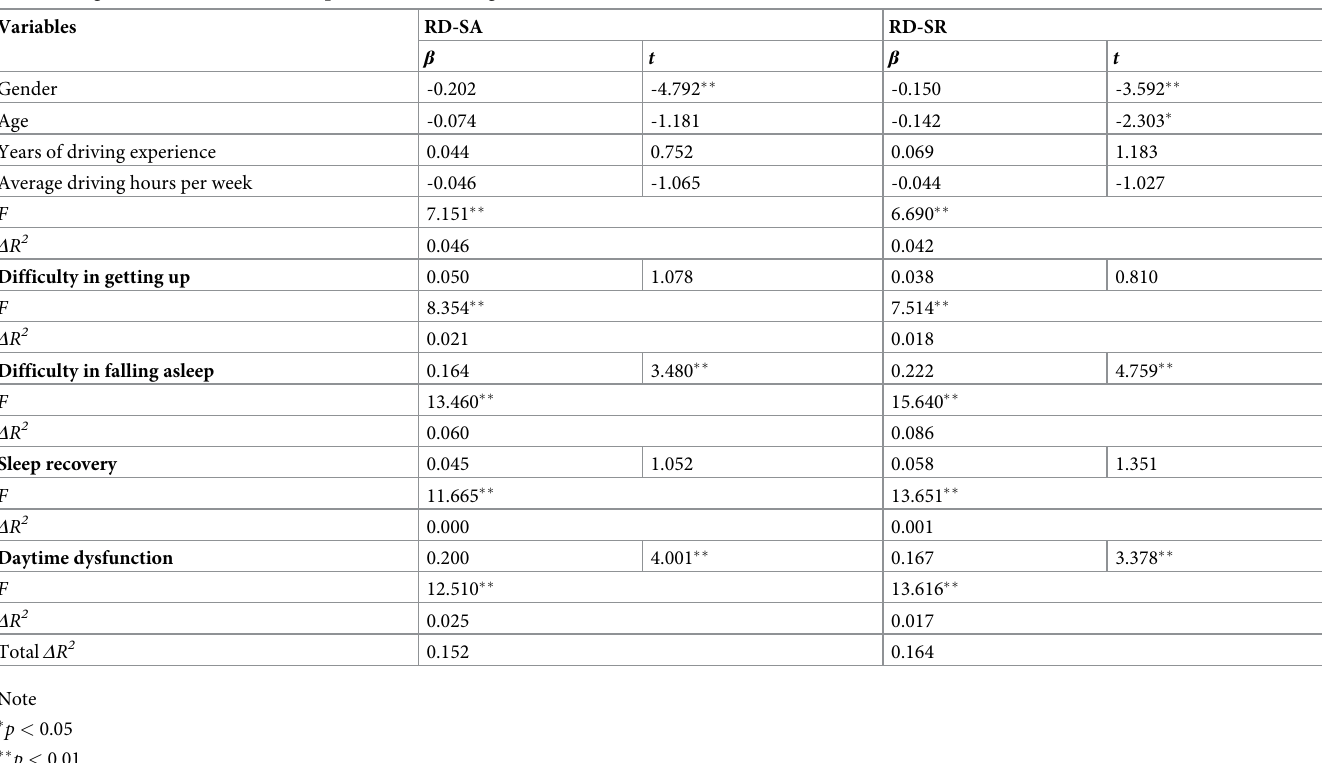
Table 5. Regression coefficients for the prediction of driving behaviours ( n = 515).